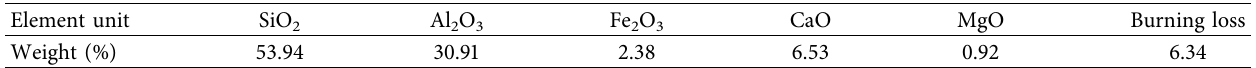
Table 2: Main chemical constituents of fly ash.